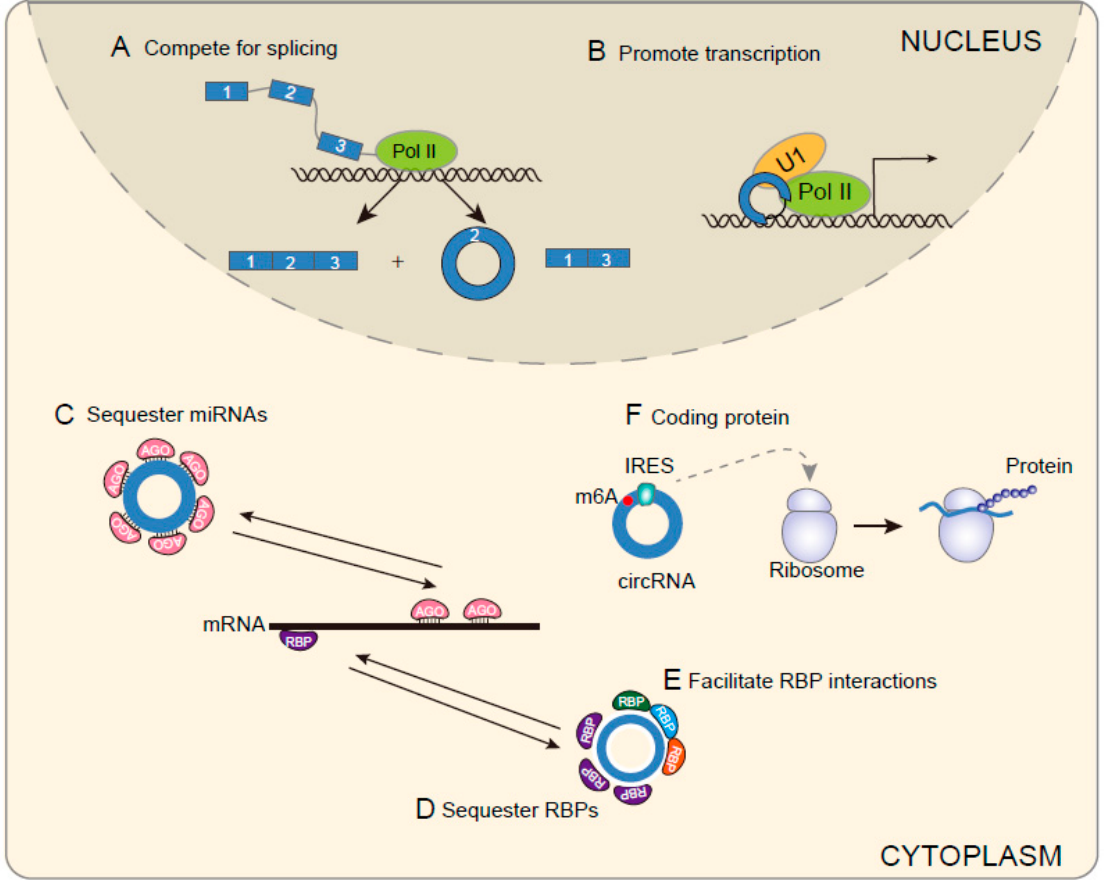
Figure 2. Regulatory roles of circRNAs. In the nucleus, ( A ) circRNAs can compete with their linear cognates splicing and promote exon skipping of their linear cognates. ( B ) EIcircRNAs or ciRNAs interact with Pol II, U1 snRNP at promoters of their parent genes, thus promote transcription of their parental genes. ( C ) CircRNAs serve as microRNA sponge and promote mRNA stability or protein production. ( D ) CircRNAs act as a decoy for RBP. ( E ) CircRNAs act as mediate to facilitate protein interaction. ( F ) CircRNAs encode functional protein when they harbor m6A motif or IRES.